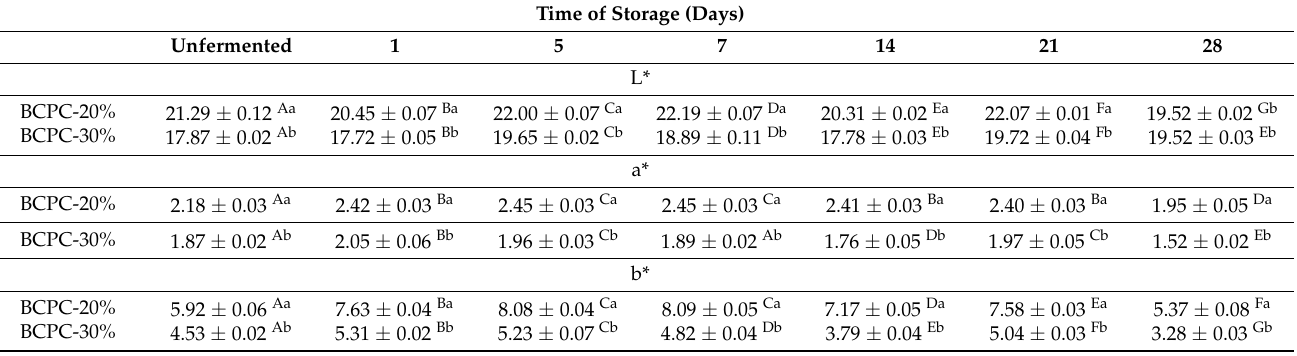
Table 3. Color values of fermented beverages and unfermented (control) samples. Time of Storage